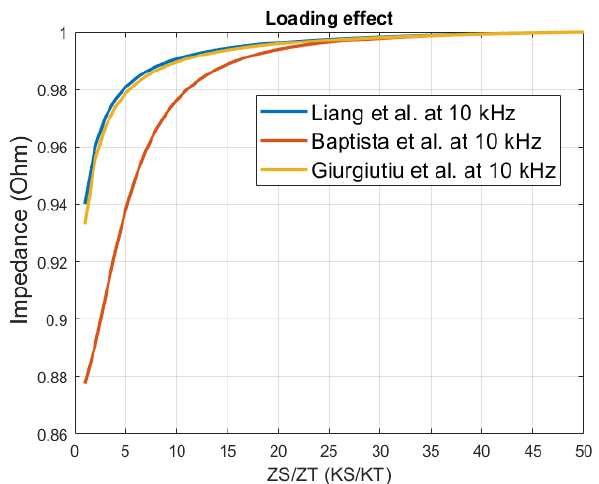
Table 1. PZT patch parameters [18].